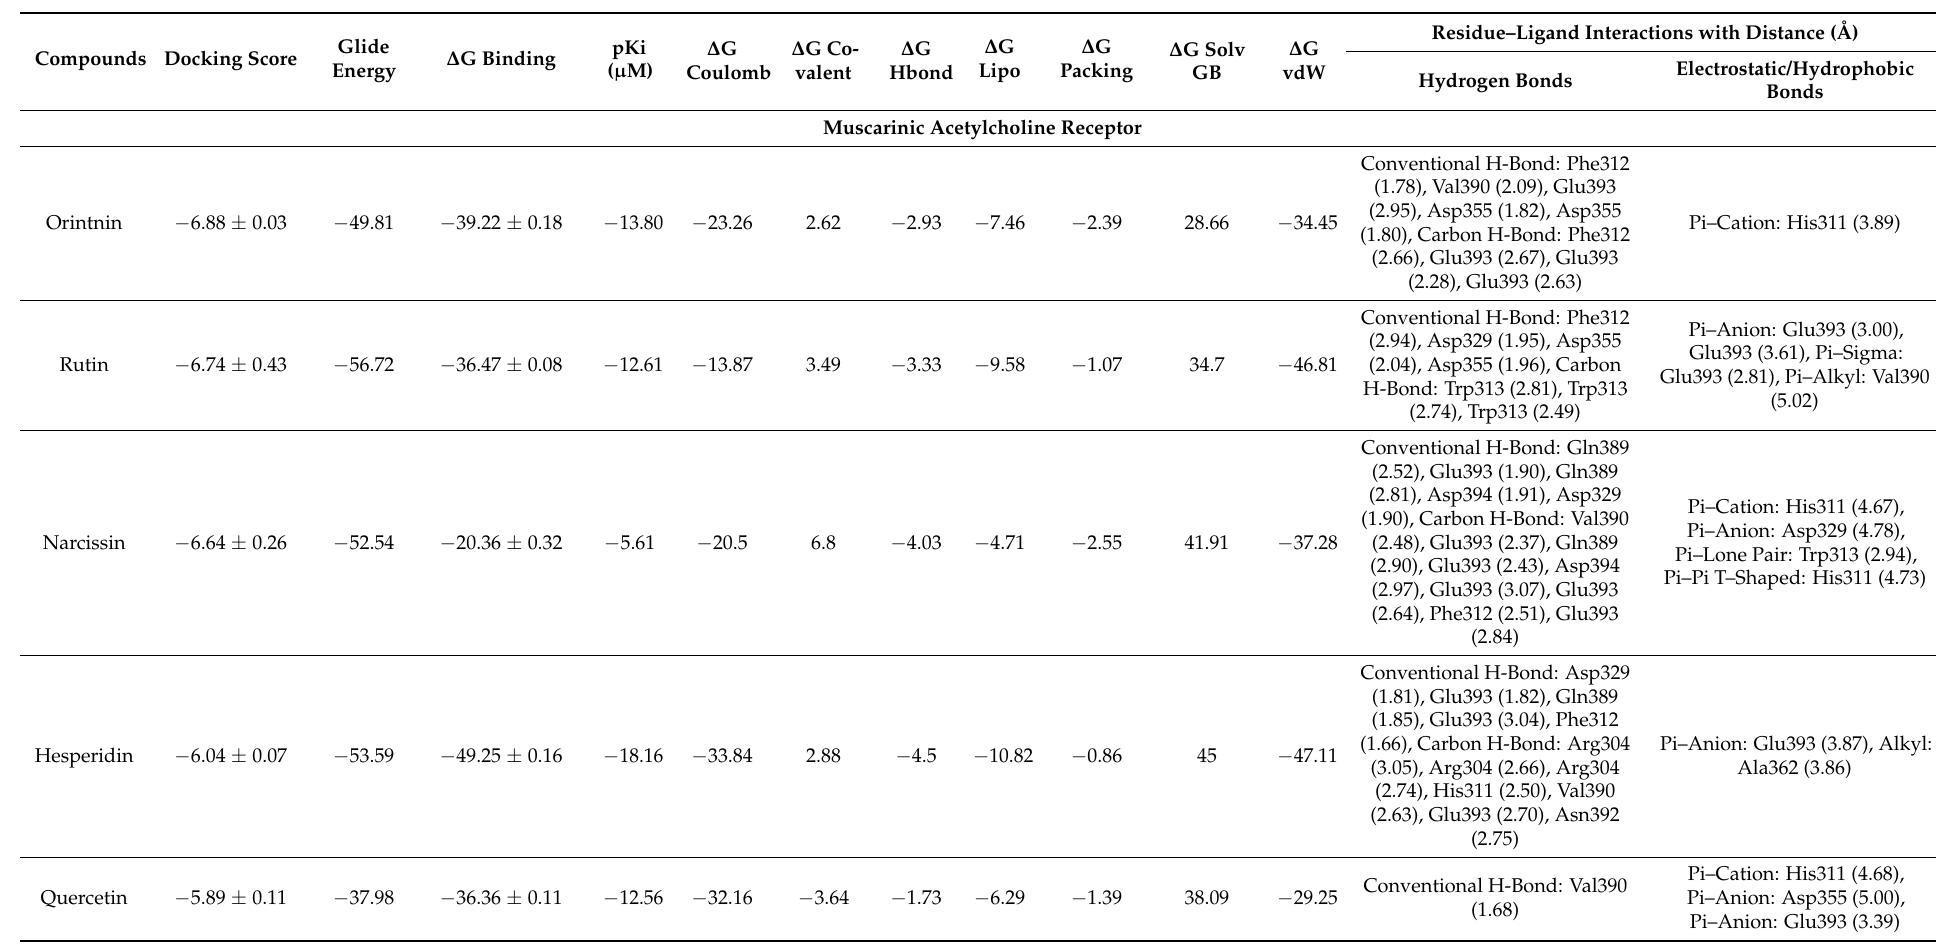
Table 1. Binding energies (kcal/mol) of compounds with voltage-gated calcium ion channel, myosin light chain kinase, and phosphoinositide phospholipase C–Gamma–1 calculated by Prime